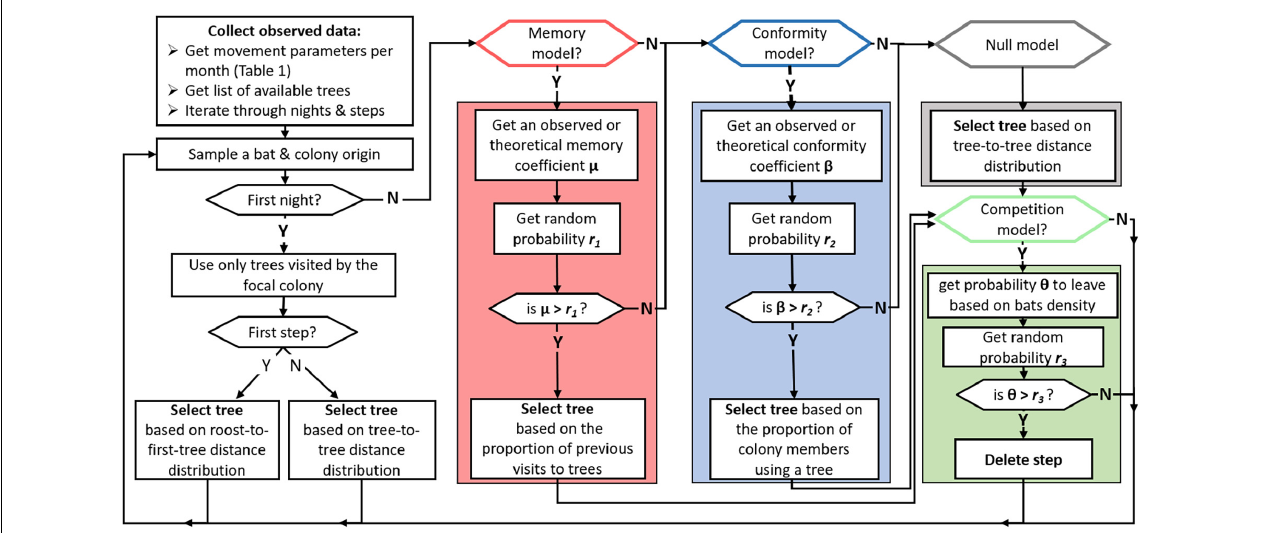
FIGURE 2 | Flowchart showing the decision-making process of a simulated bat at each step (tree visit) of the agent-based models. A step begins by sampling a bat-agent and ends with a tree selection. Colored frames represent the null model (gray) or the implementation of the different mechanisms that are hypothesized to affect resource and spatial partitioning—memory (red), conformity (blue) and competition (green). At the end of the simulation, each colony is attributed a set of trees from which the between-colony partitioning indices (WTO and WAO) are